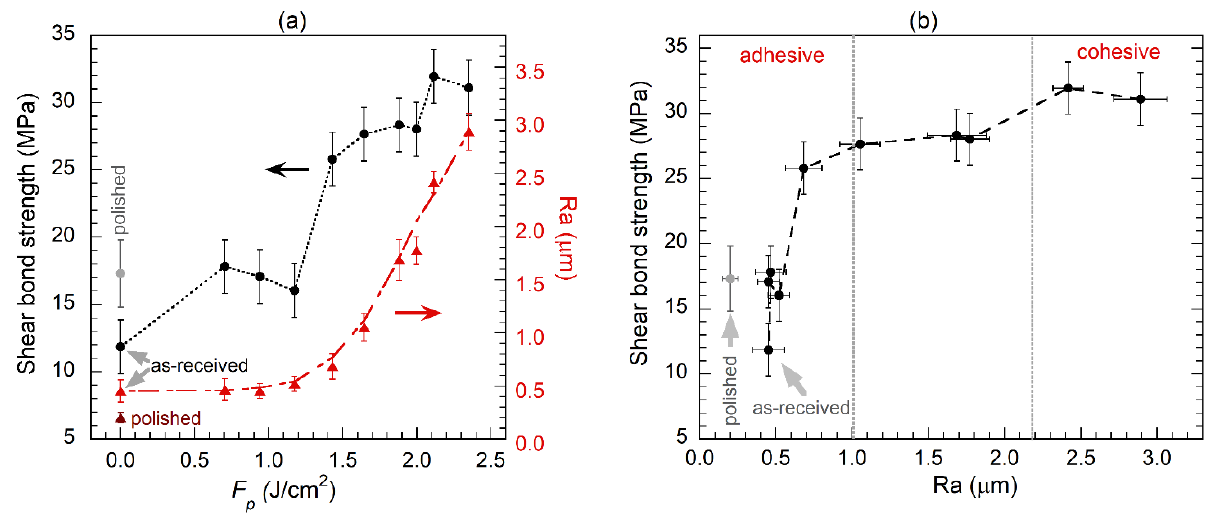
Figure 8. ( a ) Shear bond strength (circles) of the Cu/epoxy/Cu and Cu surface average roughness (triangles) as a function of the pulse fluence for LSM processing. The two represented values for non-irradiated samples correspond to as-received and polished surfaces, as indicated. ( b ) Shear bond strength as a function of Ra (same data as in figure ( a )).